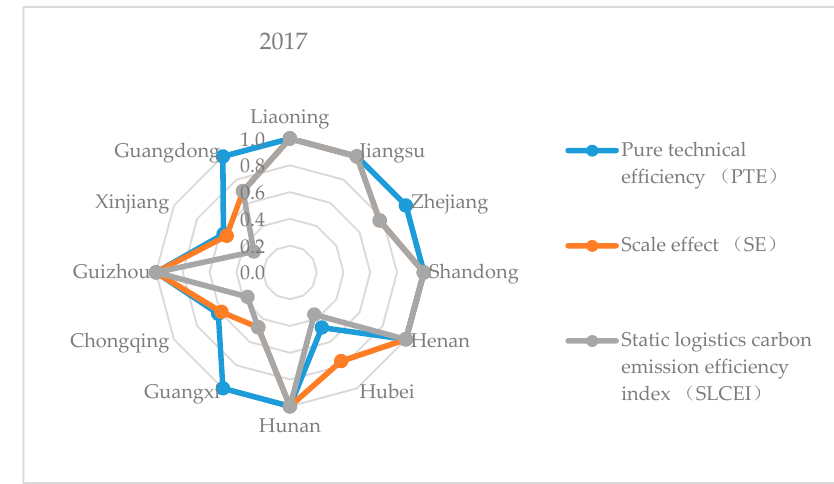
Figure 4. Static carbon emissions efficiency index for the logistics industry (SLCEI) along with the pure technical efficiency (PTE) and scale efficiency (SE) values in the pilot regions.